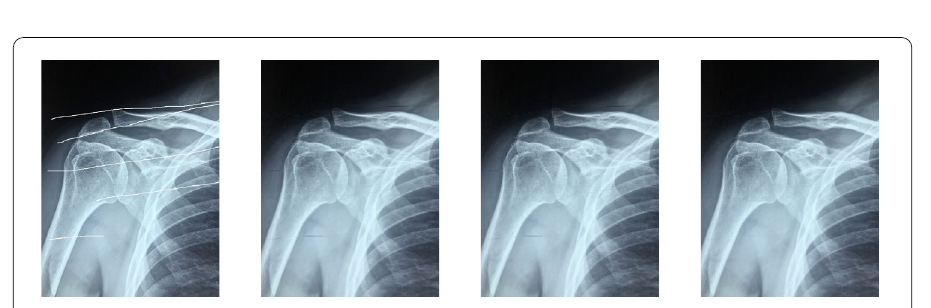
Figure 7 The missing and restored images by Algorithm 1.1 (PSNR: 26.3070, SSIM: 0.9375), Algorithm 1.2 (PSNR: 26.6354, SSIM: 0.9381), and Algorithm 3.6 (PSNR: 27.6598, SSIM: 0.9400)